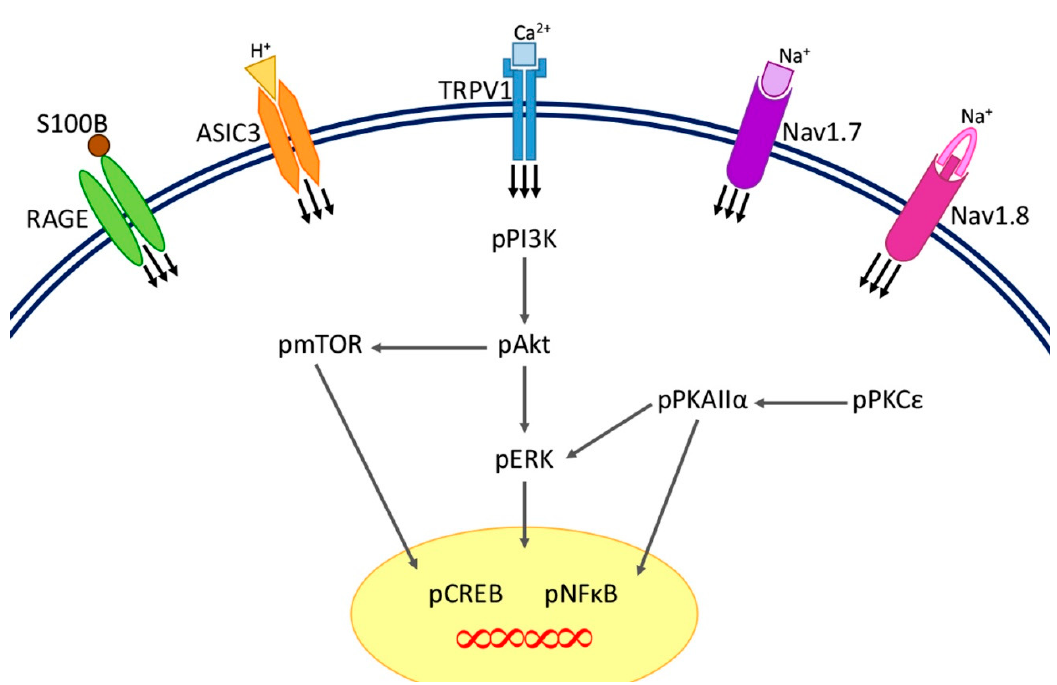
Figure 7. Illustration of inflammatory pain pathways attenuated by EA in the cerebellum. We found